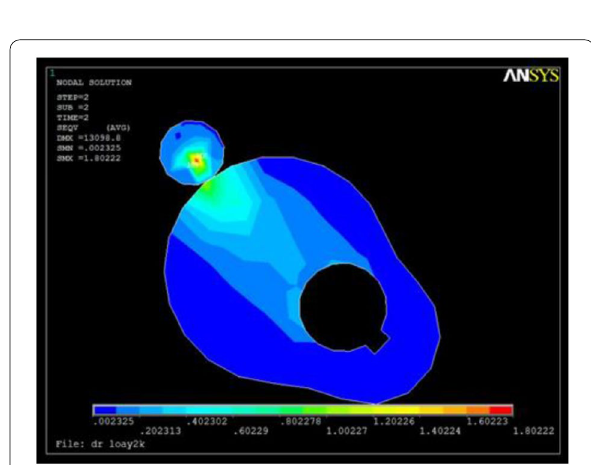
Figure 23 Contact stress contour when the follower located at 180° with the cam